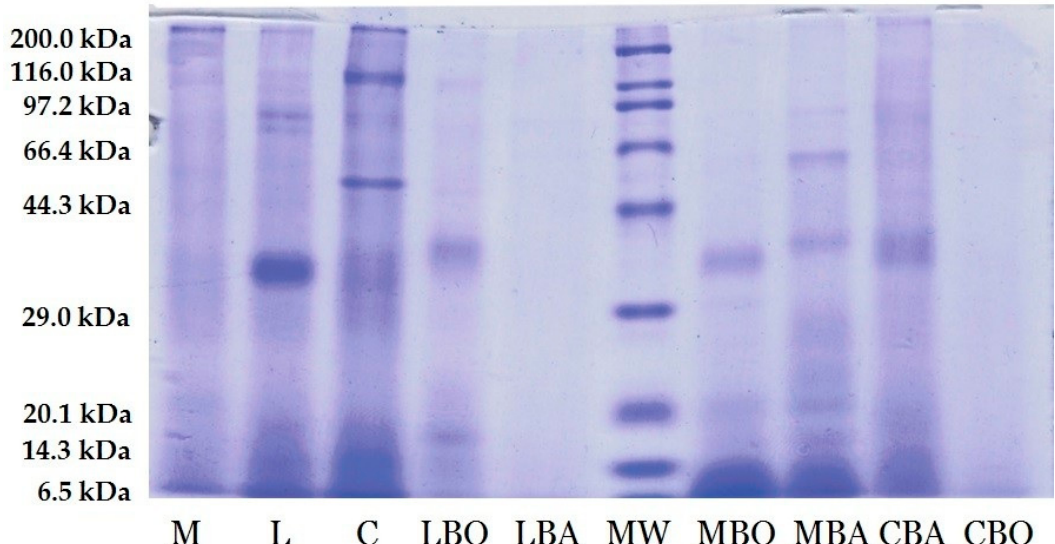
Figure 1. Electrophoretic (sodium dodecyl sulfate polyacrylamide gel electrophoresis) pattern of insect protein. Lane: M = raw mealworm T. molitor , L = raw locust S. gregaria , C = raw cricket G. sigillatus , LBO = boiled locust S. gregaria , LBA = baked locust S. gregaria , MBO = boiled mealworm T. molitor , MBA = baked mealworm T. molitor , CBA = baked cricket G. sigillatus , CBO = boiled cricket G. sigillatus , MW = molecular mass